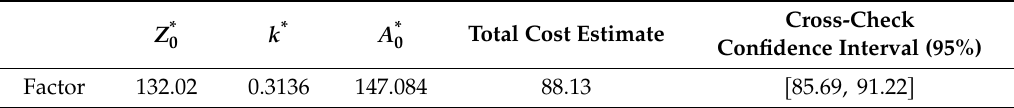
Table 5. Optimal control parameters and cross-check validation.